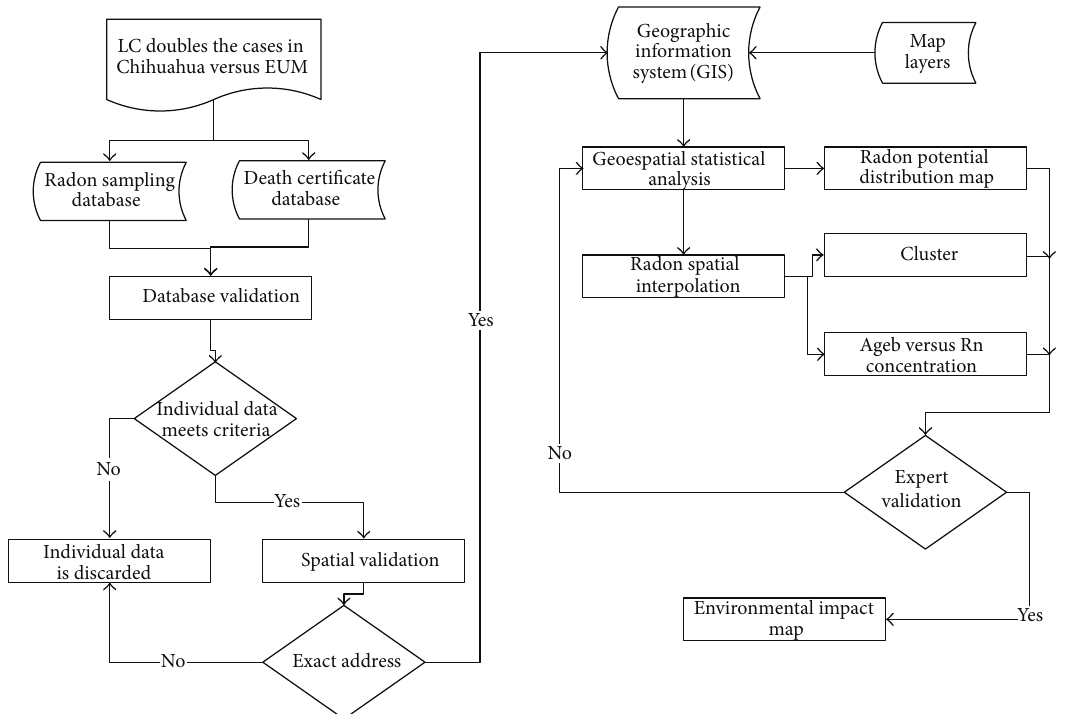
Figure 1: Working flowchart for the analysis of the databases. The criteria and methodology applied are described in the corresponding unit.